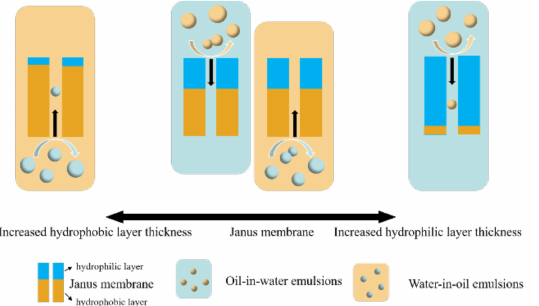
Figure 9. The influence of hydrophilic layer thickness and the mechanism of the Janus